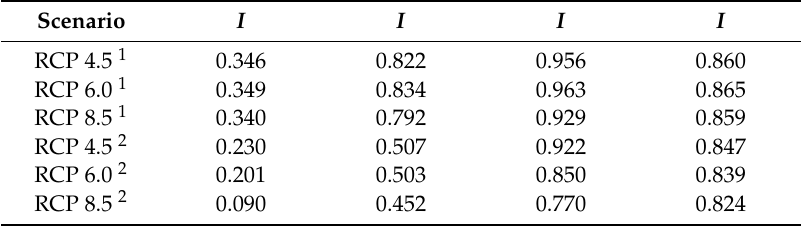
Table 7. Indices for climate change representative concentration pathways (RCP)